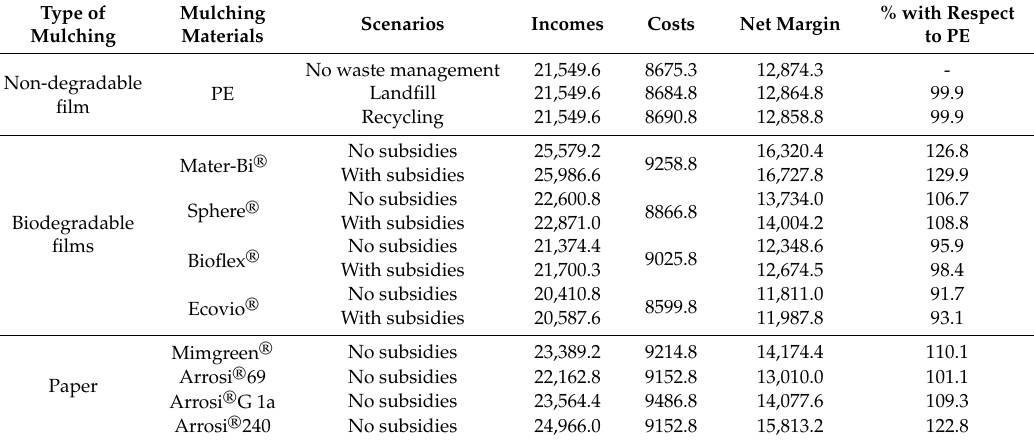
Table 6. Incomes, costs, and net margins of di ff erent mulching materials ( € ha − 1